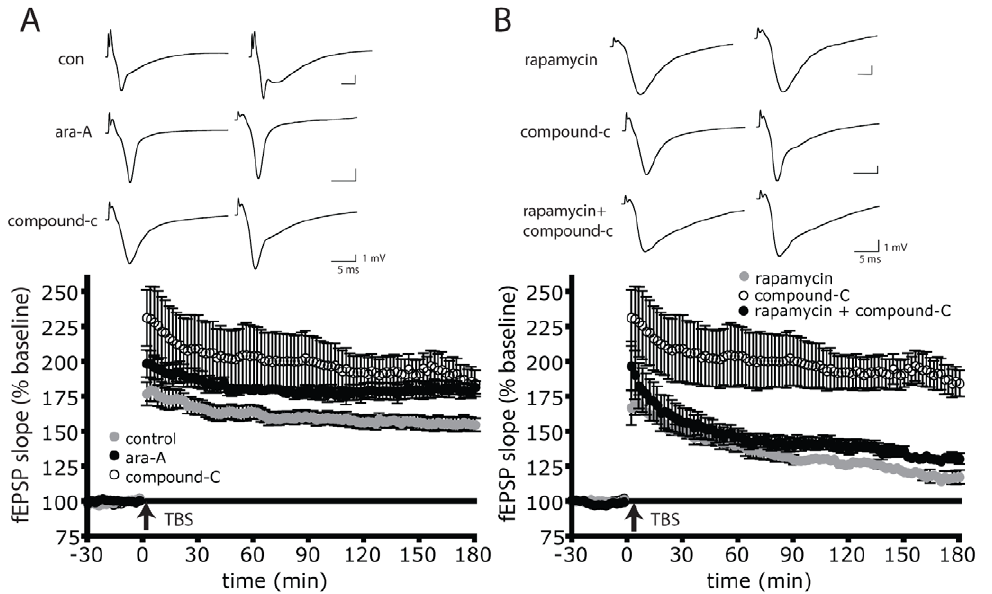
Figure 6. AMPK regulation of L-LTP is rapamycin sensitive. A) 1 m M compound-C (n=8, p=0.0069) or 100 m M ara-A (n=8, p=0.0045) results in heightened potentiation after TBS compared to ACSF alone (n=14). B) 1 m M rapamycin results in suppression of L-LTP to 33% of control (n=4, p=0.0097). 1 m M compound-C in the presence of rapamycin fails to significantly enhance L-LTP above rapamycin alone (n=9, p=0.2706). Control data in Fig. 6A is reproduced in Fig. 6B for comparison. Inset: Representative fEPSP traces shown were taken 4 minutes prior to and 180 minutes after TBS. Error bars show s.e.m.